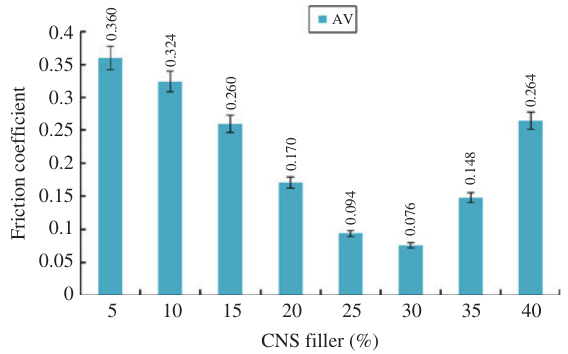
Figure 10: Friction coefficients of the treated CNS filler epoxy com- posites with various filler contents.